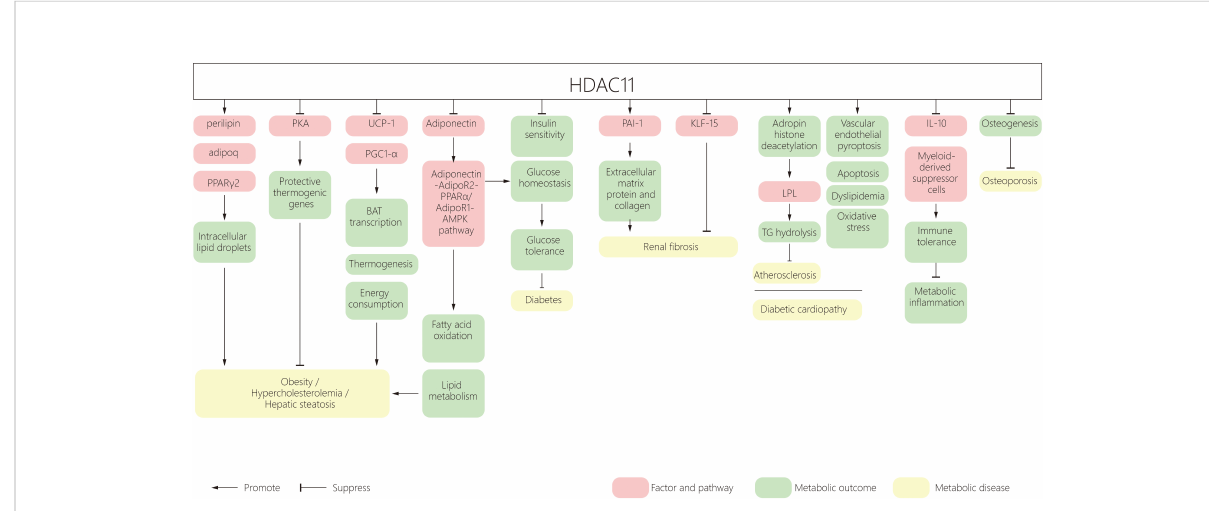
FIGURE 1 A schematic diagram of HDAC11 and its effect on metabolic disorders. HDAC11, Histone deacetylase 11; PPAR, peroxisome proliferator ‐ activated receptor; BAT, brown adipose tissue; UCP1, uncoupling protein 1; AMPK, AMP-activated protein kinase; PAI ‐ 1, Plasminogen agonist inhibitor type 1; AP-2 a , activator protein 2 a ; KLF15, Kruppel-like factor 15; LPL, Lipoprotein lipase; TG,